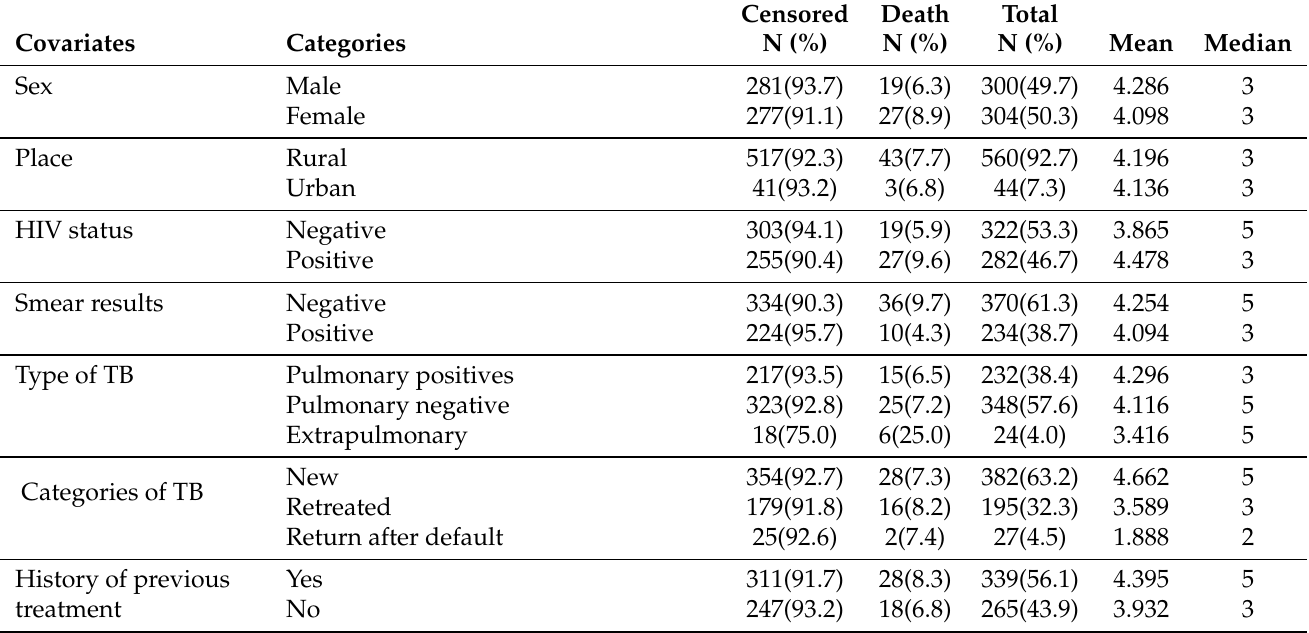
Table 1. Characteristics of tuberculosis patients under DOTS program from randomly selected governmental hospitals in southwest